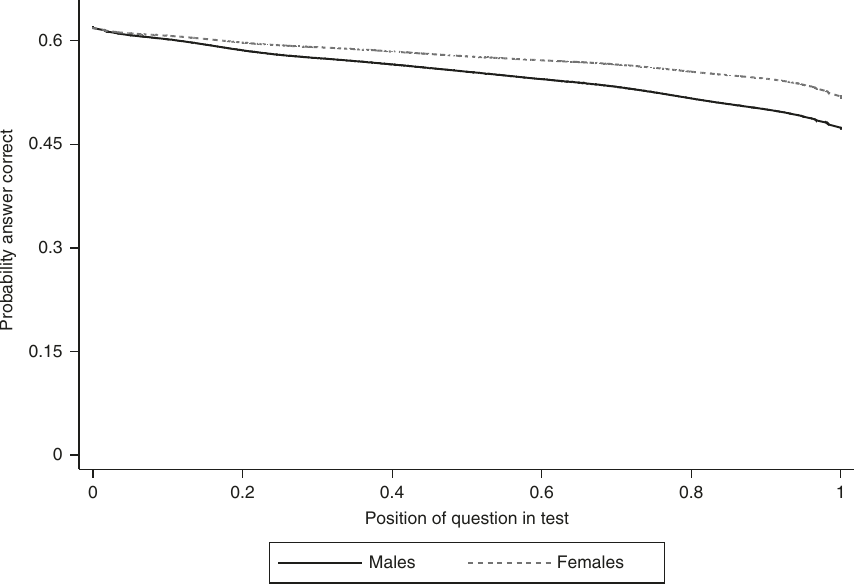
Fig. 1 Performance throughout the test for males and females in Ireland. The fi gure is based on the PISA 2009 and uses Locally Weighted Scatterplot Smoothing (LOWESS) to visualize the relationship between the probability to answer a question correctly and the position of the question in the test. Source data are provided as a Source Data fi le (study